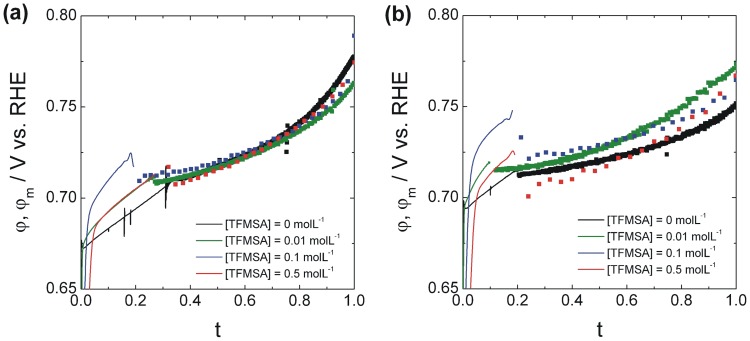
Normalized curves during methanol oscillatory oxidation for selected currents.Galvanostatic curves found for applied currents with values of (a) 0.3 mA and (b) 0.4 mA and different solution compositions. Time was normalized for each series by the instant where 10 oscillations cease to exist.